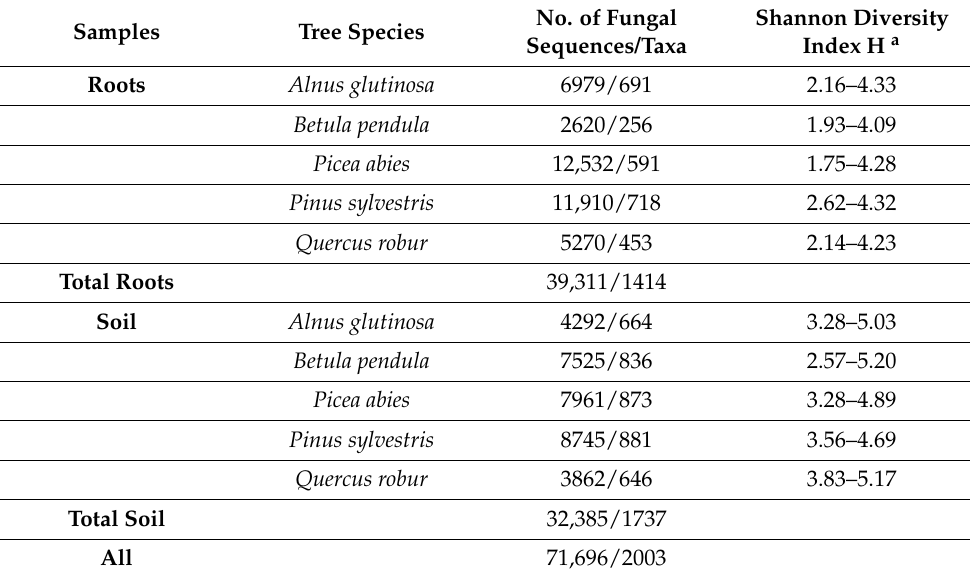
Table 2. Generated high-quality fungal sequences and the detected diversity of the fungal taxa in the roots and soil of the five different tree species from the seven forest nurseries in Lithuania. The data from the different forest nurseries are combined.